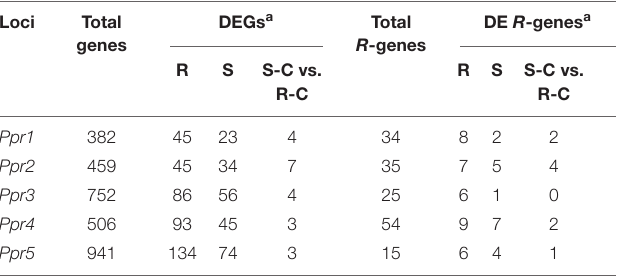
TABLE 3 | The total number of genes identified underlying known resistance loci, showing the percentage of total and differentially expressed R -genes in both resistant and susceptible